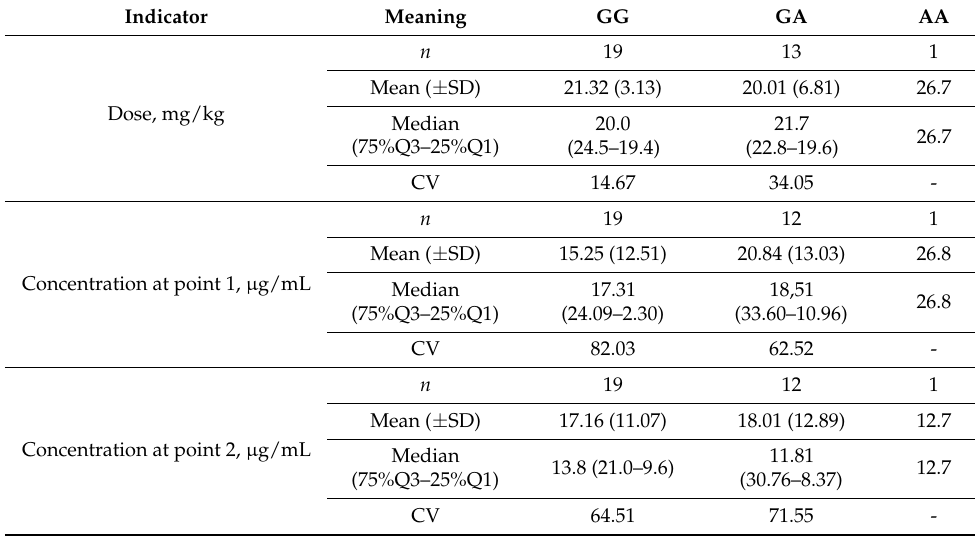
Table 8. Pharmacokinetic parameters of CPF in patients with various genotypes in patients with different genotype variants: GG, GA, AA of the CYP2D6*4 gene (1846G >